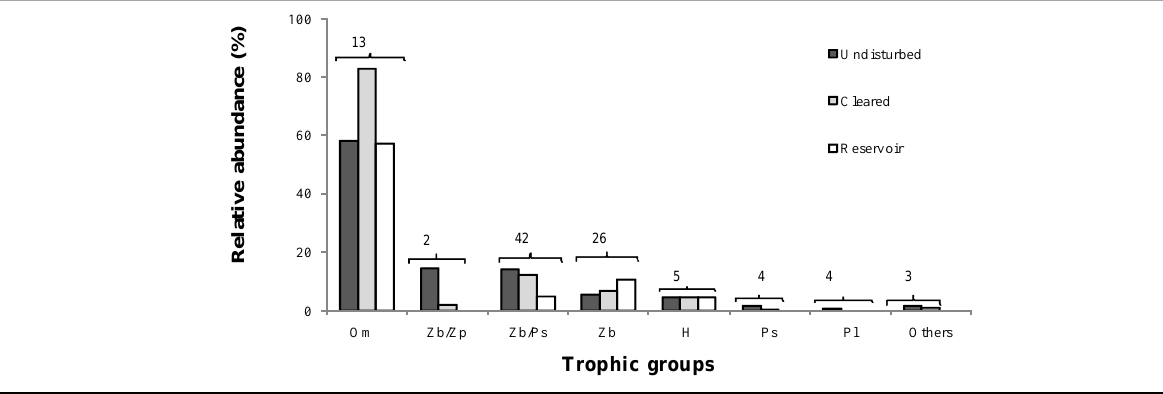
bund a e l R Trophic groups Figure 3: Overall relative proportions in abundance of various feeding guilds in mangrove creek systems subjected to deforestation, cleared only and reservoirs for salt and fish farms along the coastline of Tanzania Note: Om = omnivores; H = herbivores; Zb = zoobenthivores Zp = zooplanktivores; Ps = piscivores; Pl = planktivores; and others = unidentified; Species number for each category are shown on